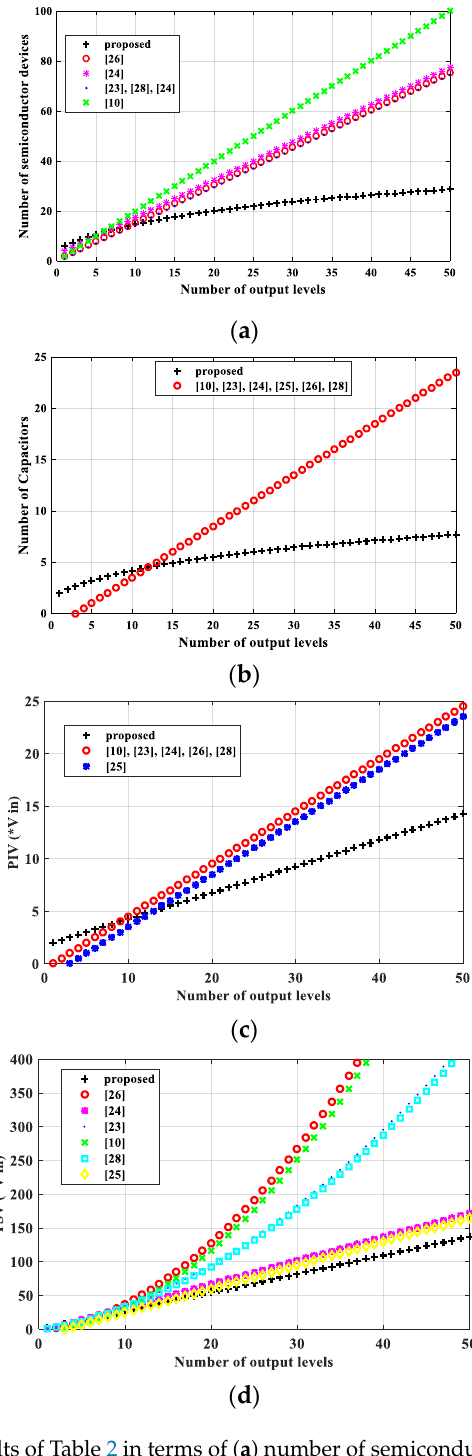
Figure 6. Comparison results of Table 2 in terms of ( a ) number of semiconductor devices ( b ) number of capacitors ( c ) peak inverse voltage (PIV) ( d ) total standing voltage (TSV).